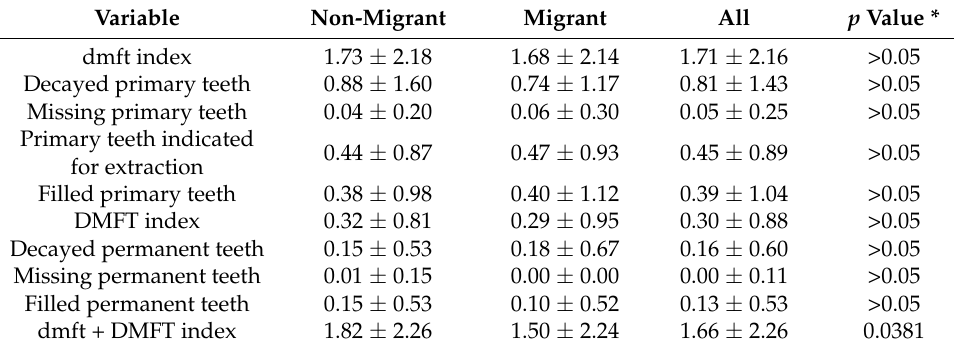
Table 2. Distribution of caries indices (primary dentition (dmft) and permanent dentition (DMFT)) and their components among non-migrant and migrant